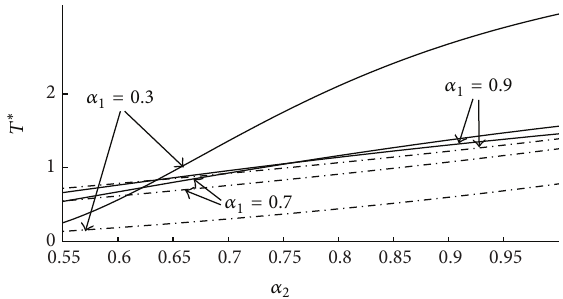
Figure 12: The dependencies for minimal control time from 𝛼 1 at different values of 𝛼 2 for 𝑝 󸀠 = 1 . Logarithmic scale used for ordinates.